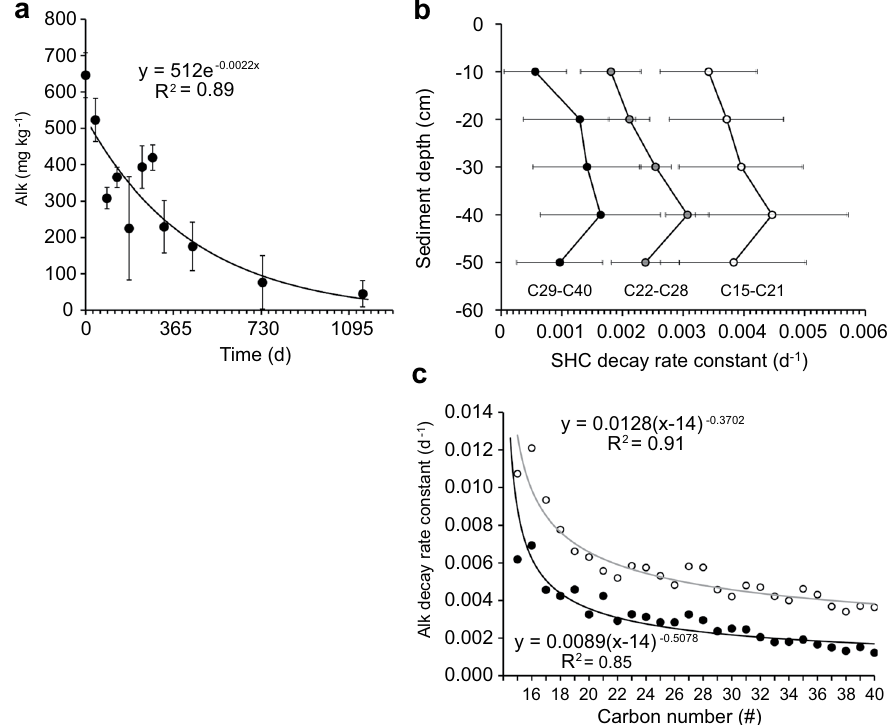
Figure 3. Alkane degradation in the sSOAs during the experiment. ( a ) Degradation of the total n -alkanes. ( b ) Decay rate constants for n -alkanes at the different sediment depths. Rate constants are averaged according to carbon numbers 15–21, 22–28 and 29–40. ( c ) Decay rate constants for C 15 -C 40 n -alkanes determined for the initial half-year (open symbols, grey line) and the 3-year time period of the experiment (solid symbols, black